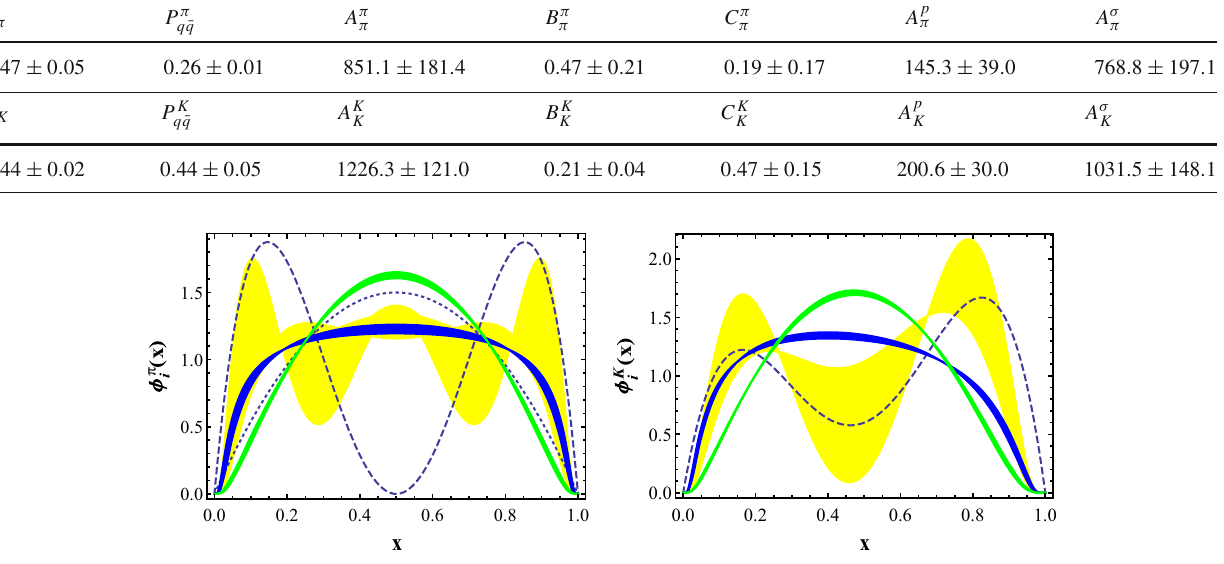
asymptotic distribution amplitude, φ asy π ( x ) = 6 x ( 1 − x ) . Right panel : ( x ) = 30 x [ 0 . 6 ( x − x ) 2 + 0 . 08 + 0 . 08 ( x − x ) Same for φ i ; φ CZ s x u s u s u K K